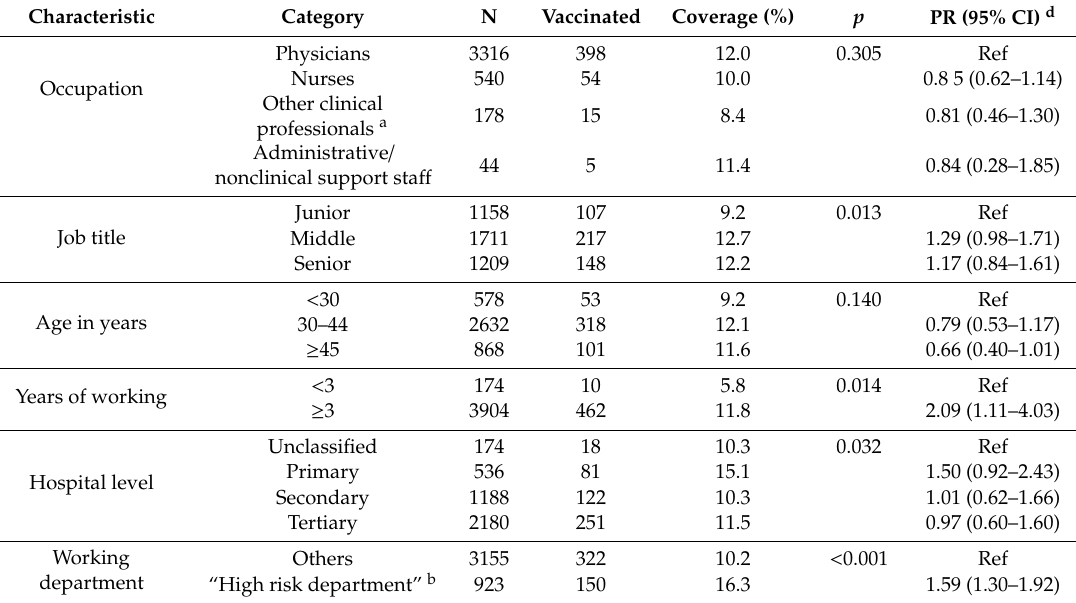
Table 2. Percentage of healthcare workers who received influenza vaccination- Internet panel survey, China, 2018–19